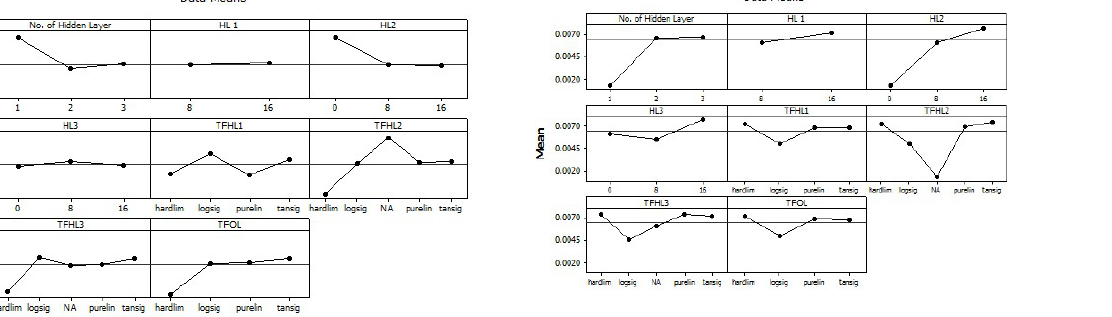
Fig.-13(b). Utility vs. Servicea- bility